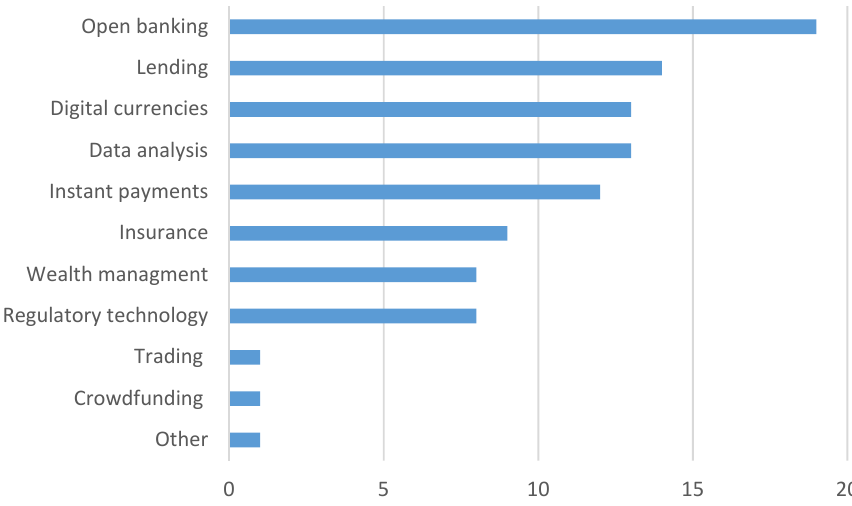
Figure 4. Potential areas of FinTech development in the future, number of answers .